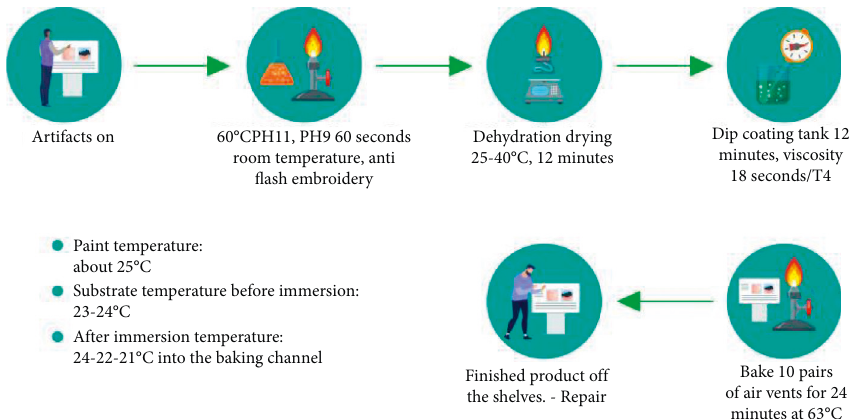
Figure 1: Chemical process of water-based acrylic dipping